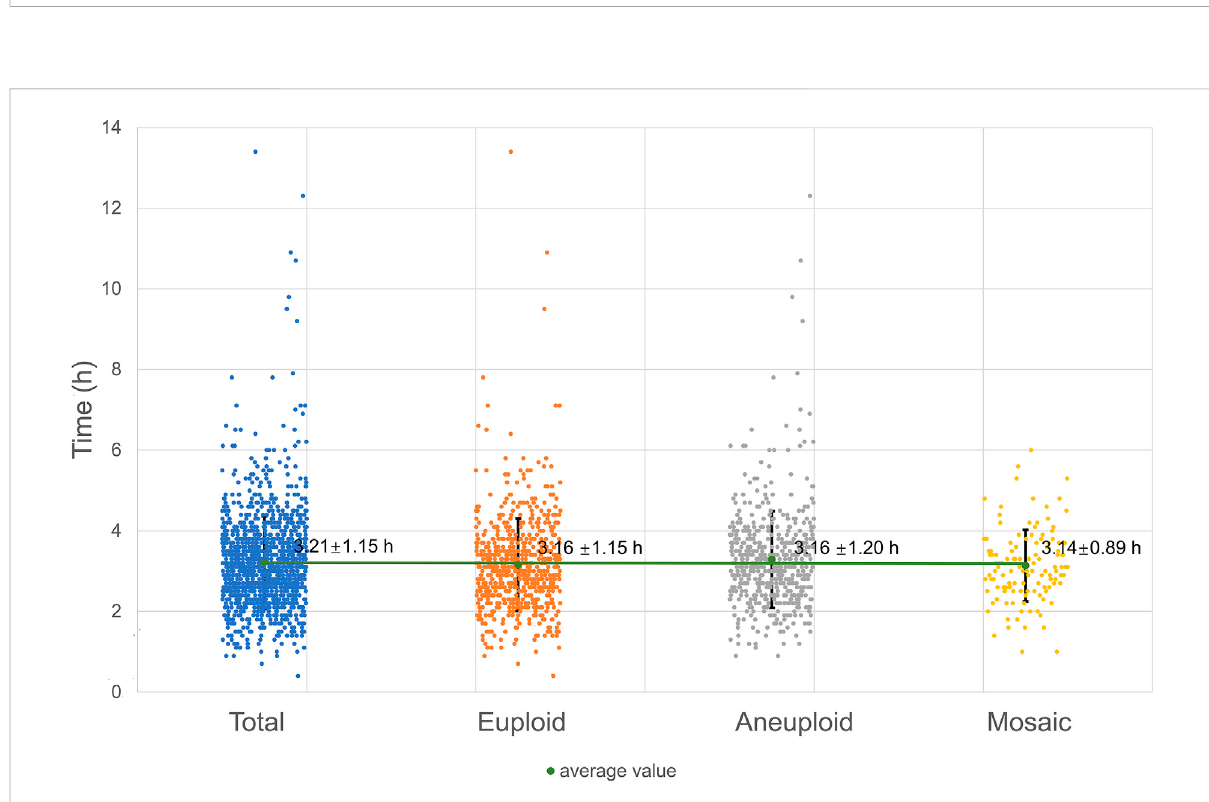
Time of the second polar body